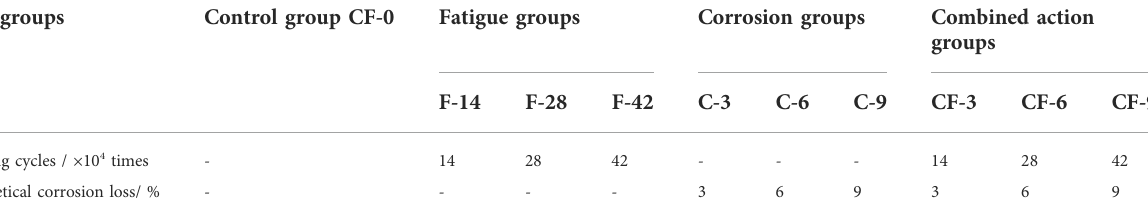
TABLE 1 Preset damage of